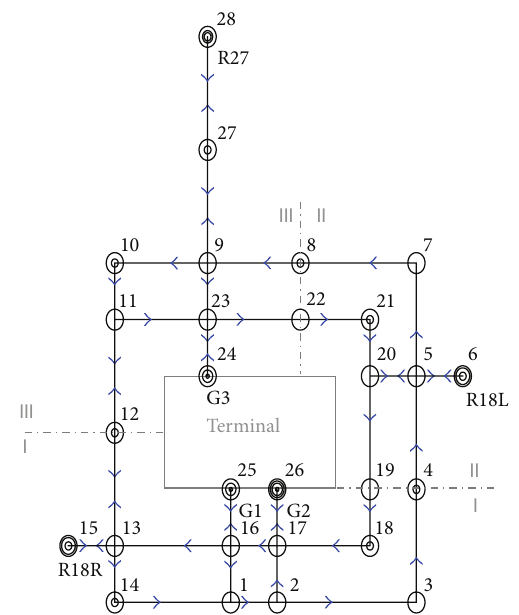
Figure 1: Example airport divided into sectors and